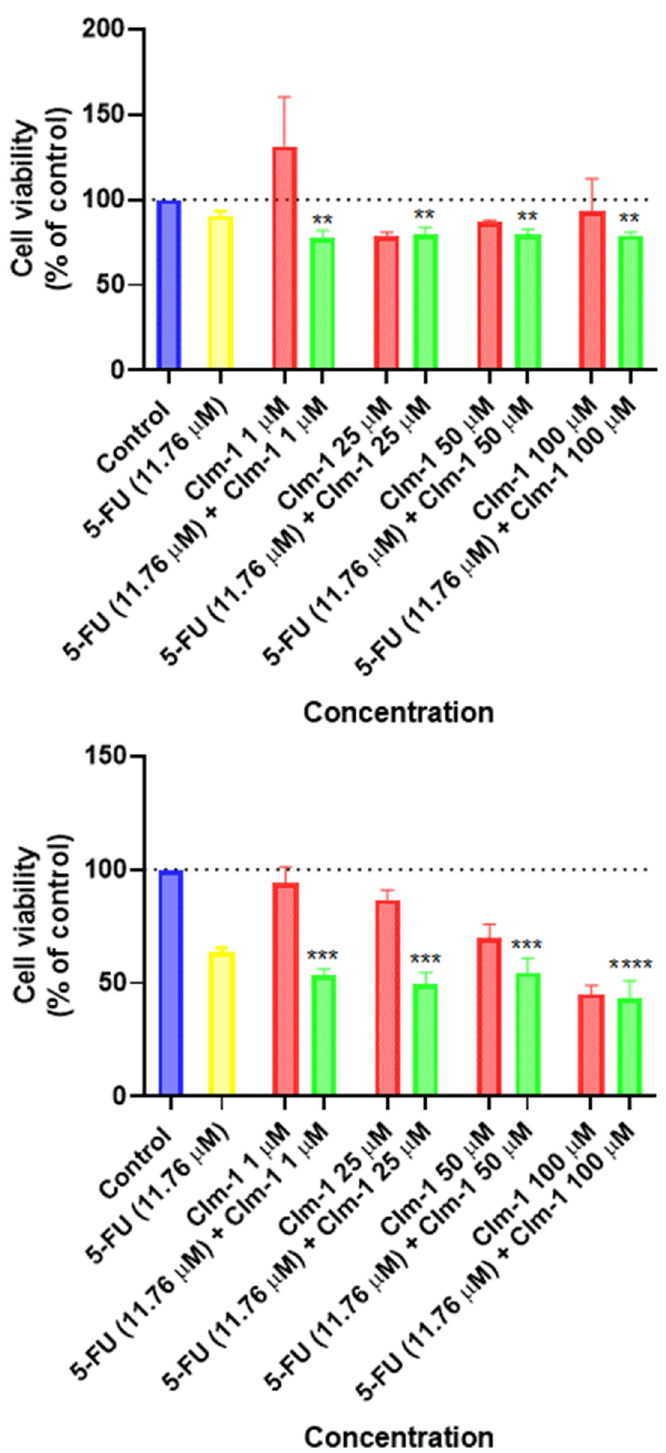
Figure 6. Cytotoxicity evaluation of the combination of 5-FU and different concentrations of Clm-1 in MCF-7 (top) and PC-3 (bottom) cancer cells. These were treated with vehicle (methanol and DMSO) and with a combination of 5-FU (11.79 µM) and increasing concentrations (0–100 µM) of Clm-1 for 48 h; cell viability was assessed by MTT assay. Data are given as the mean ± SEM ( n = 3), ** statistically significant vs. control (vehicle) at p < 0.01; *** statistically significant vs. control (vehicle) at p < 0.001.**** statistically significant vs. control (vehicle) at p < 0.0001. Starting with MCF-7 breast cancer cell lines (Figure 6), increasing the concentration of Clm-1 does not lead to relevant variations in cellular viability. This is expected, as this